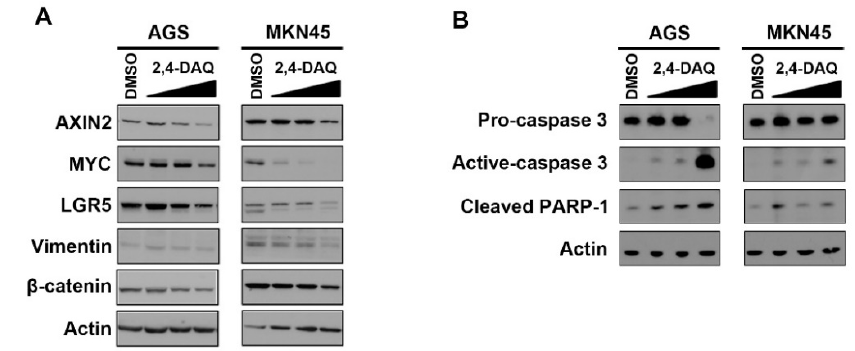
Figure 3. 2,4-DAQ regulates Wnt/ β -catenin responsive genes and induces caspase 3-dependent apoptosis in gastric cancer cells. The AGS and MKN45 cells were treated with different concentrations of 2,4-DAQ (100, 200 and 300 μ M) or control (DMSO) for 48 h. Total lysates of cells were analyzed by western blot analysis with specific antibodies against ( A ) Wnt/ β -catenin pathway ( A ) and ( B ) apoptosis-related proteins as indicated. Actin represents the loading controls.